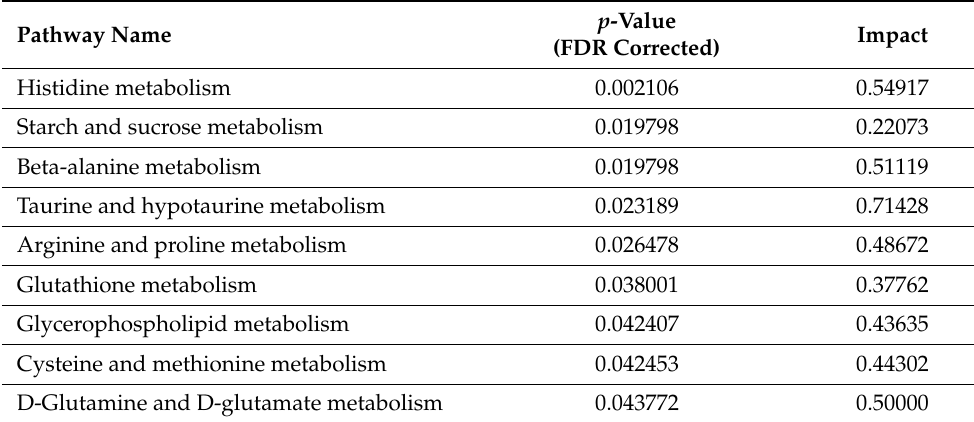
Figure 1. Partial-Least Squares — Discriminant Analysis results. ( A ) score plot for the individual birds, represented by red (severe WB) or black (no WB) symbols; circles (• or •) indicate that they had no WS, squares ( ▪ or ▪ ) moderate WS, and stars ( * or * ) severe WS. ( B ) Y Loadings plot for the response parameters, severity of Wooden Breast (WB) and White Striping (WS). This plot uses the same layout as plots ( A , C ) and shows how the response variables (WB and WS) associate with the individual animals (plot ( A )) and the various metabolites that survived the very important parameter selection (plot ( C )). ( C ) Loadings plot for the metabolites remaining after two rounds of very important parameter selection). ( D ) close-up of the yellow rectangle in ( C ). Table 3. Pathway analysis results using MetaboAnalyst. The p -value was calculated using path- way enrichment analysis and the impact was calculated using pathway topological analysis using betweenness centrality and using Gallus Gallus as a pathway